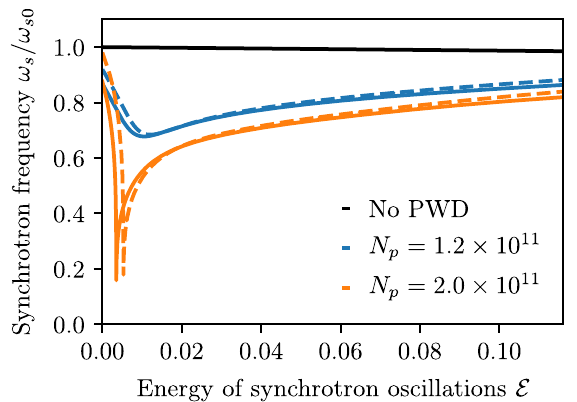
FIG. 10. Synchrotron frequency as a function of synchrotron- oscillation energy for different intensities and E lines are for single-rf potential, while dashed lines are for a parabolic-rf potential (linear rf voltage). The black curve illus- trates the case without PWD.